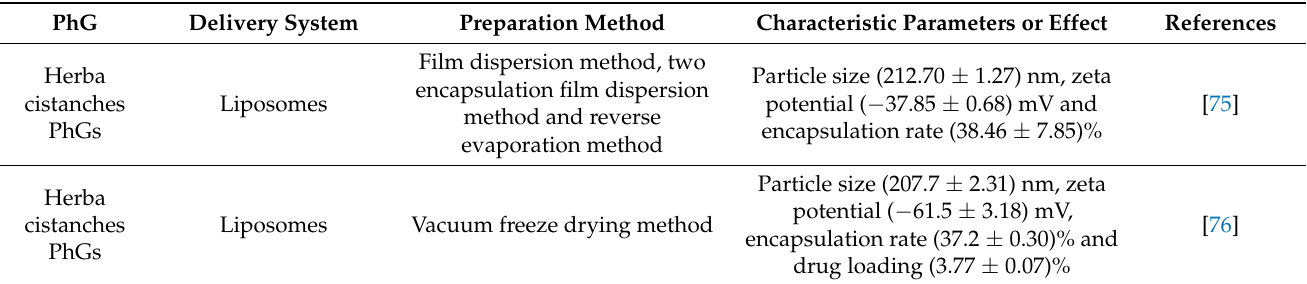
Table 3. The application of PhG delivery